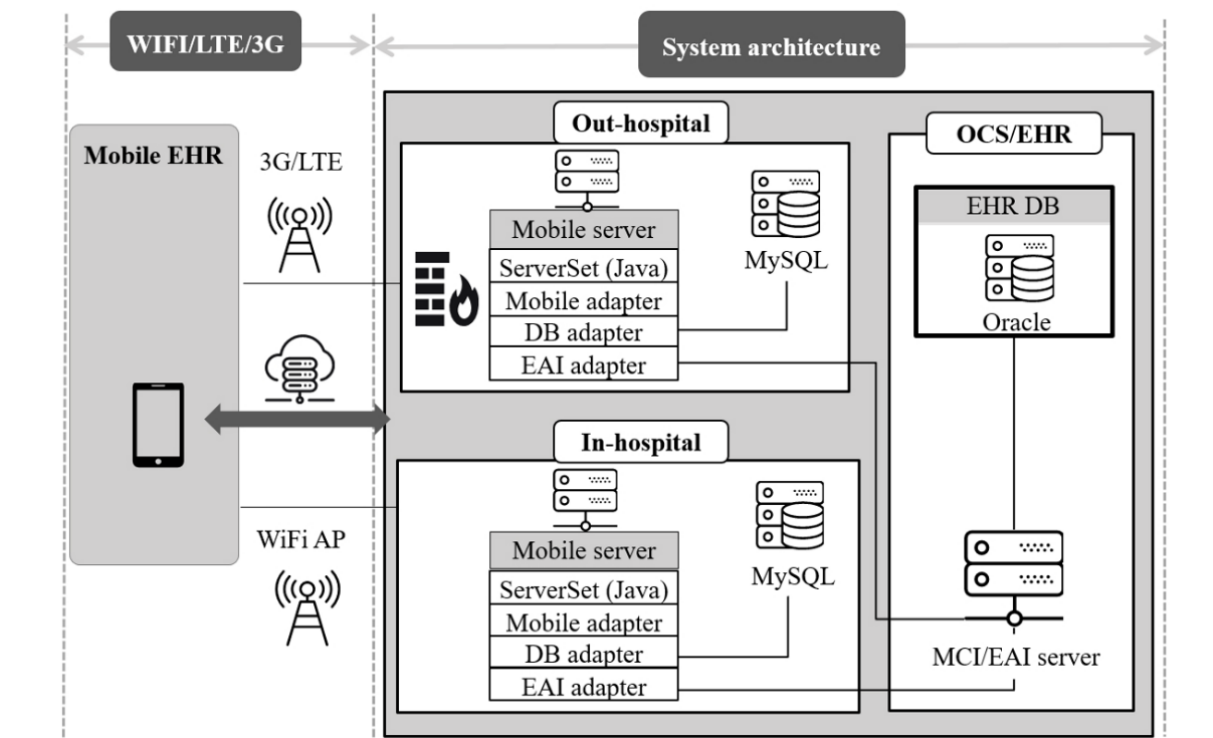
Figure 2. System architecture of mDARWIN. It was designed to accommodate 2 different network connectivity choices. AP: access point; DB: database; EAI: enterprise application integration; EHR: electronic health record; LTE: long-term evolution; MCI: multi-channel integration; OCS: order communication system; SQL: structured query